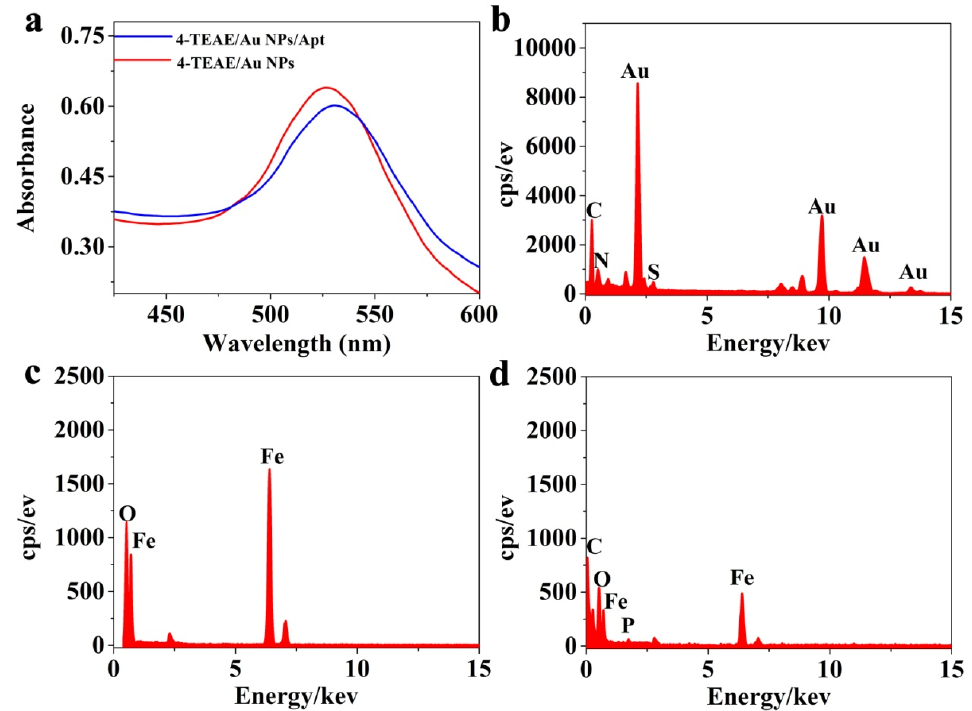
Figure 3. ( a ) UV − vis spectrum of 4-TEAE/Au NPs (red) and 4-TEAE/Au NPs/Apt (blue). EDS spectroscopy of ( b ) 4-TEAE/Au NPs/Apt, ( c ) Fe 3 O 4 NPs and ( d ) and Fe 3 O 4